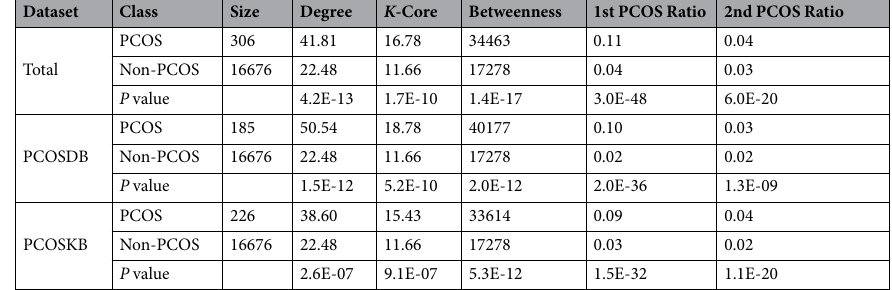
Table 1. Network Characteristics of PCOS Genes. “Total” indicates all the PCOS genes covered by either PCOSDB or PCOSKB. “Non-PCOS” indicates the remaining genes. The degree of a gene is defined as the number of its direct interaction genes. A K -core of a network can be obtained by recursively deleting genes with a degree lower than K , until the remaining genes in subnetwork have a degree higher than K . Betweenness counts the number of times that a gene is on the shortest path between two other genes. 1st PCOS ratio is defined as the ratio of the number of PCOS genes that it direct interacts to its degree. 2nd PCOS ratio is defined as the ratio of the number of PCOS genes that belong to 2nd interaction genes to its number of 2nd interaction genes. The P values were calculated by KS test. PCOS represents polycystic ovary